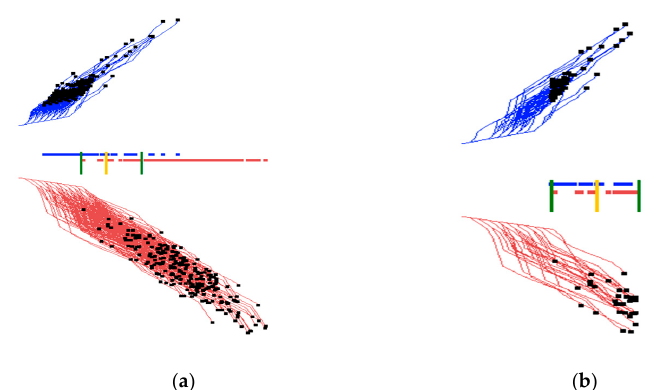
Figure 3. Interactive GLC-L setting with sliding green bars to define the overlap area of two classes for further exploration.( a ) Interactive defining of the overlap area of two classes; ( b ) Selected overlapped n-D points.